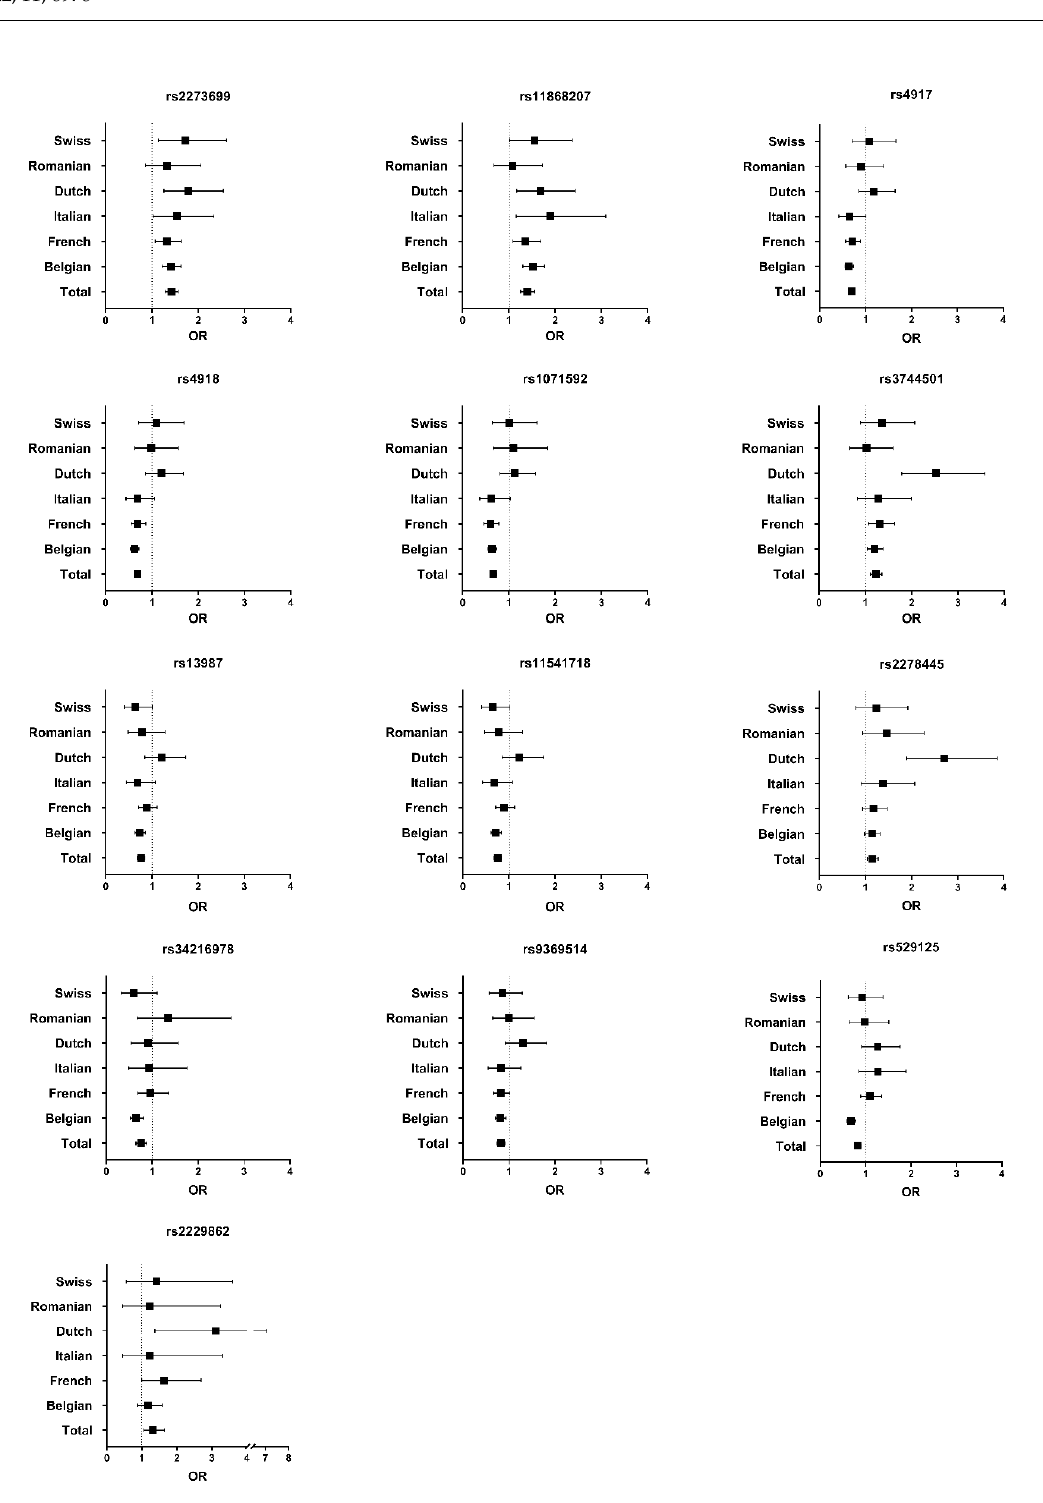
Figure 2. Forest plot of odds ratios of all 13 significant variants across all subpopulations and the total population. For each variant the odds ratio (OR) is represented by a square and the 95% confidence interval by a horizontal line. Association is considered to be consistent across all populations when the OR is lower (or higher) than one across all subpopulations. The plot shows a (near) consistent association in 9 out of 13 variants.